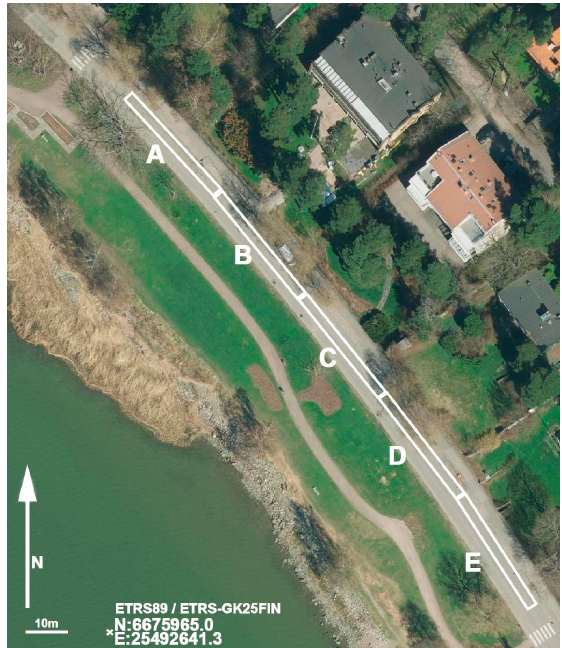
Figure 1. The full area of measurement and the analysed road surface segments A, B, C, D, and E. [31] (Orthophotograph © Helsinki City Survey Department, 2017).